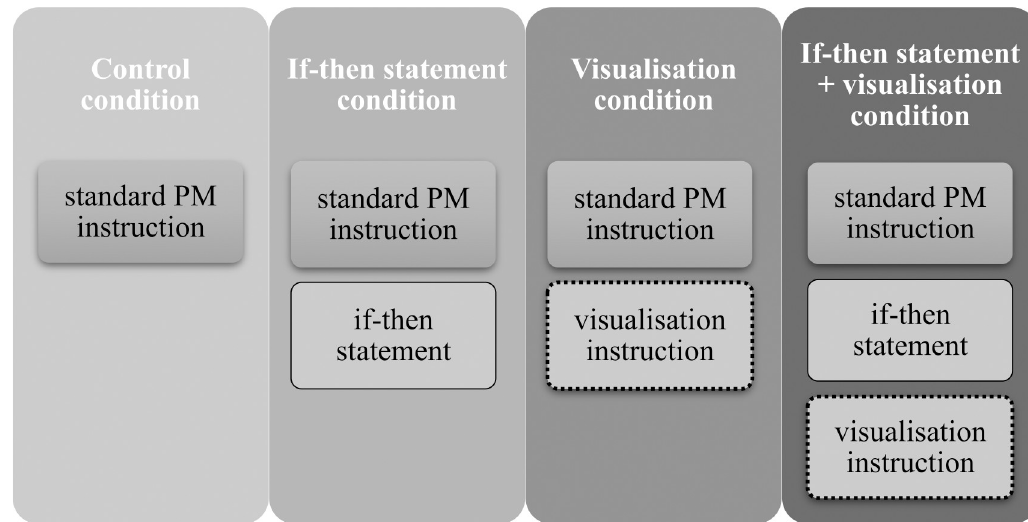
Fig 1. The combination of the instruction elements provided in each experimental